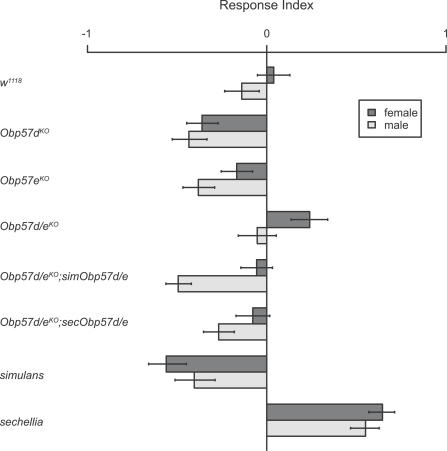
Olfactory Response of Obp57d/e Knock-Out Strains to HA in the Trap AssayResponse index (RI) = (Nh − Nw)/(Nh + Nw), where Nh is the number of individuals trapped in 1% HA solution, and Nw is that of individuals trapped in distilled water. At least 300 individuals were tested in five replications of the assay. Error bars indicate 95% confidence intervals determined by the binominal test.